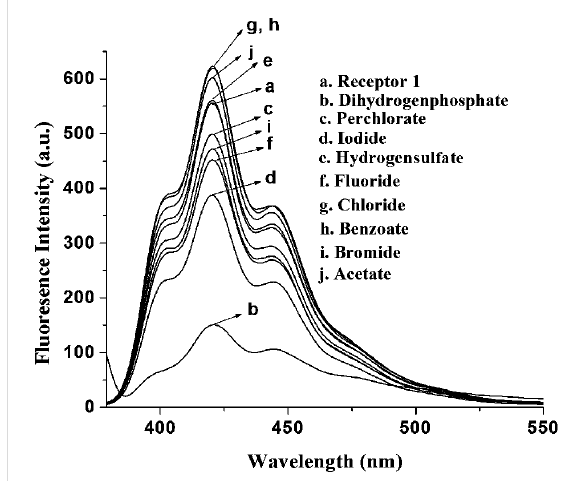
Figure 3: Change in fluorescence emission of 1 ( c = 5.78 × 10 − 5 M) in the presence of 2 equiv of tetrabutylammonium salts of different guests in CH 3 CN.